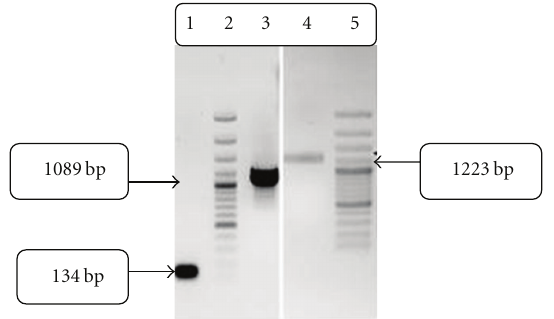
Figure 3: Gel-electrophoresis analysis of PCR-products of chimeric truncated t-PA on 1% agarose gel. Lane 1: 134 bp forward PCR product; signal sequence + GHRP. Lane 3: 1089 bp Reverse PCR product; GHRP-SYQ-K2S. Lane 4: 1223 bp full-length SOEn PCR product signal sequence + GHRP-SYQ-K2S. Lane 2&5: 1kb ladder.